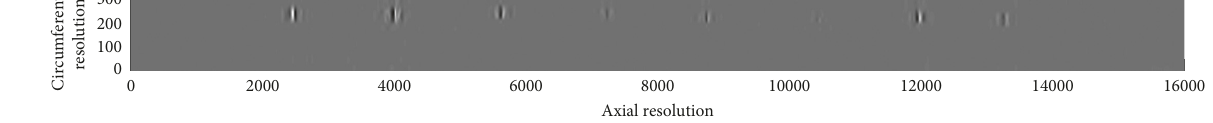
Figure 11: The MFL grayscale